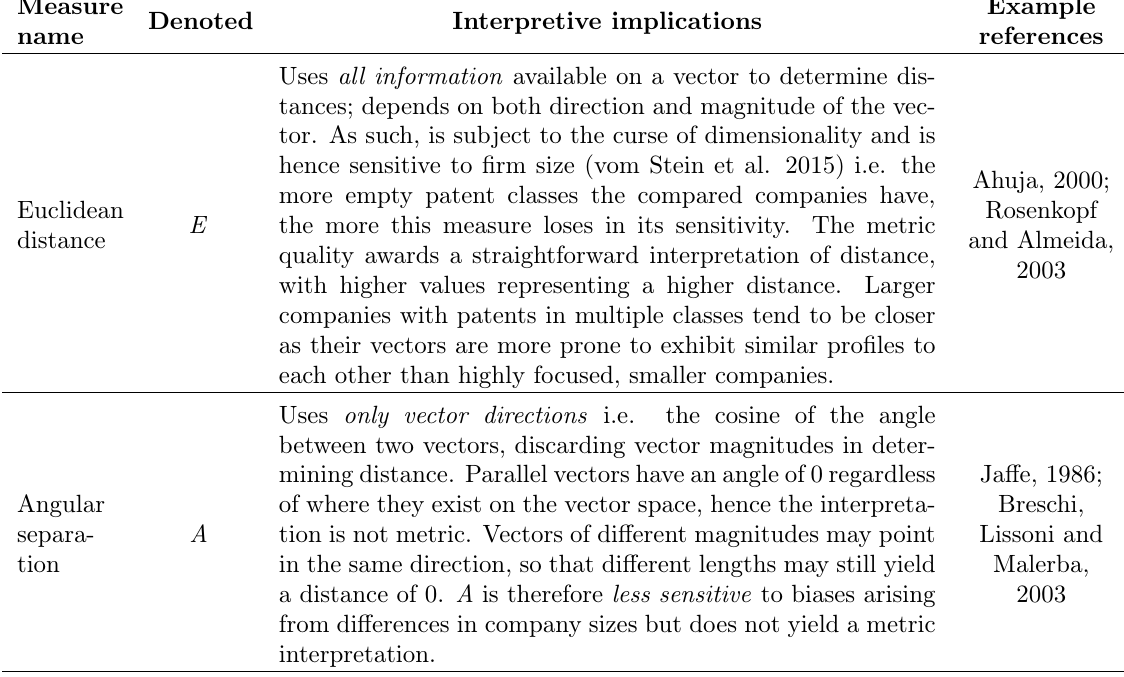
Table 1. Comparison of Euclidean distance, Angular separation, and Min-complement measures applied in the present